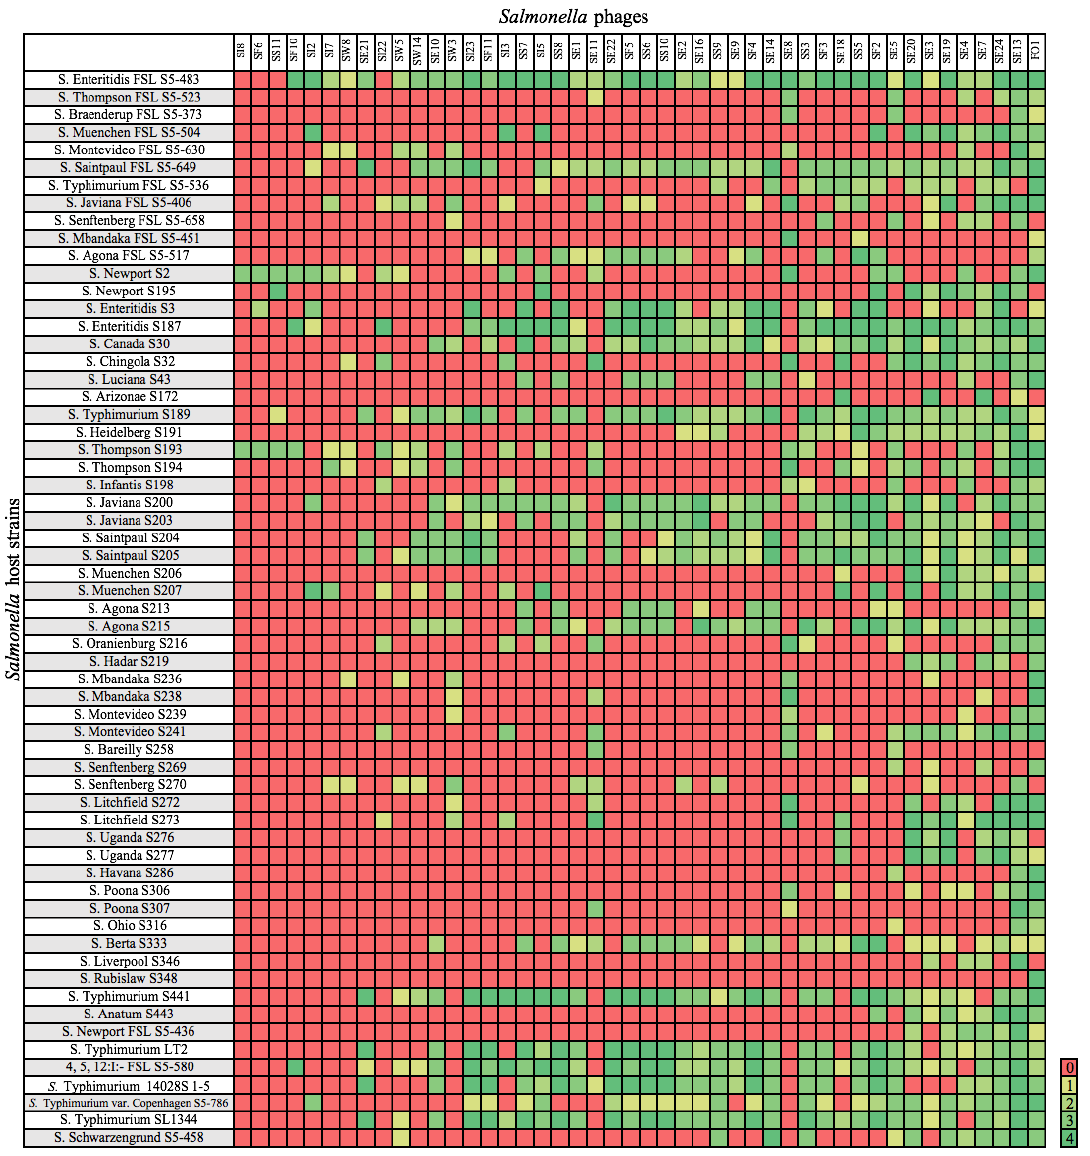
Figure 1. Host range of isolated phages. Salmonella strains susceptible to phage infection are indicated by a clearing of 1 to 4; 0 = no